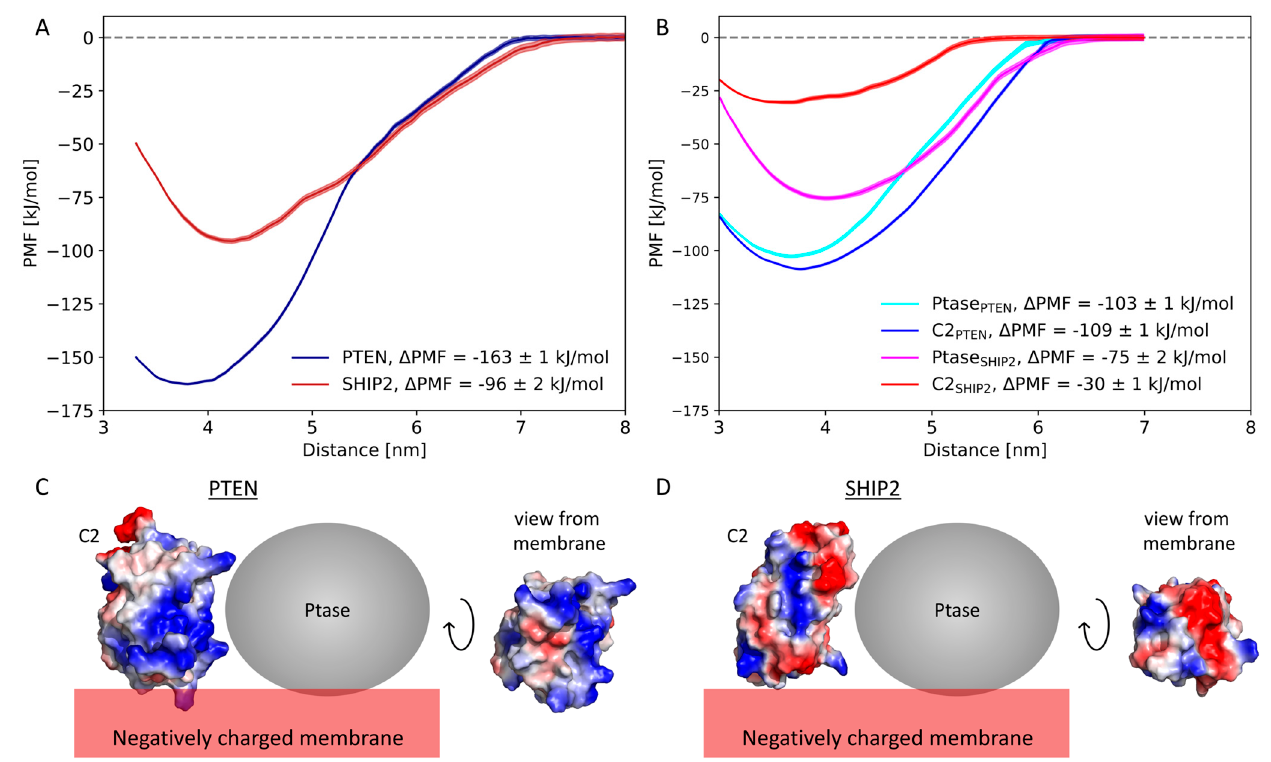
Figure 4. Binding energies as estimated by the potential of mean force: ( A ) Full-length PTEN (blue) and SHIP2 (red). Shaded areas show one standard deviation spread. ( B ) Ptase (light blue) and C2 (dark blue) from full-length PTEN. Ptase (purple) and C2 (red) from full-length SHIP2. Mean ± 1 standard error, estimated by bootstrapping [24]. Binding energy ( ∆ PMF) was defined as the difference between the minimum PMF value and the value in bulk. ( C , D ) Electrostatic surface of C2 PTEN ( C ) and C2 SHIP2 ( D ), with blue indicating positive and red indicating negative charge. Positions of the negatively charged membrane and the Ptase domains are indicated schematically.